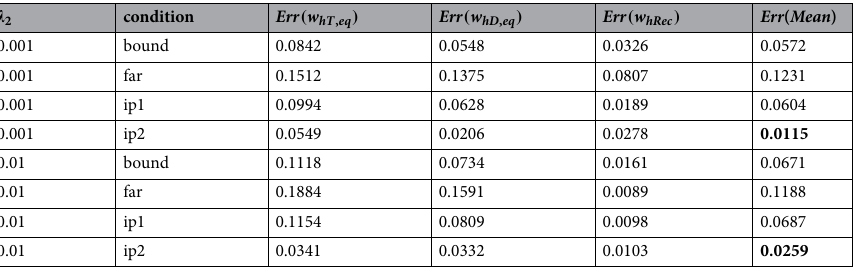
Table 3. Error values for Physical Model-4 for (cid:31) 2 = 0.001, 0.01 values. Err ( w hT , eq ) , Err ( w hD , eq ) and Err ( w hRec ) are the error values in the trapping equivalent, detrapping equivalent and recombination coefficients of the holes respectively. Err ( Mean ) is the arithmetic mean each of these error values. Hole injections are at voxel 24, 26 and 28. Significant values are in [bold].